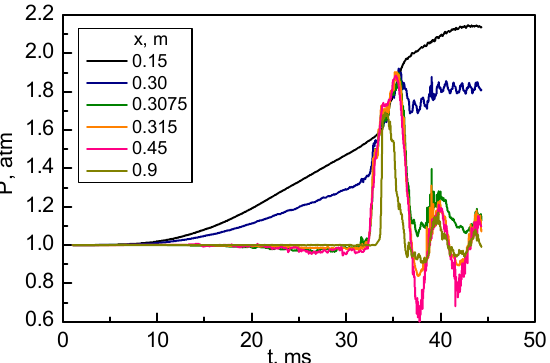
Figure 7. Pressure time histories at six positions on the symmetry line: middle of the closed chamber (0.15 m), entrance, middle, and exit of the hole in the obstacle (0.3, 0.3075, and 0.315 m), middle of the open chamber, and near the exit (0.9 m).